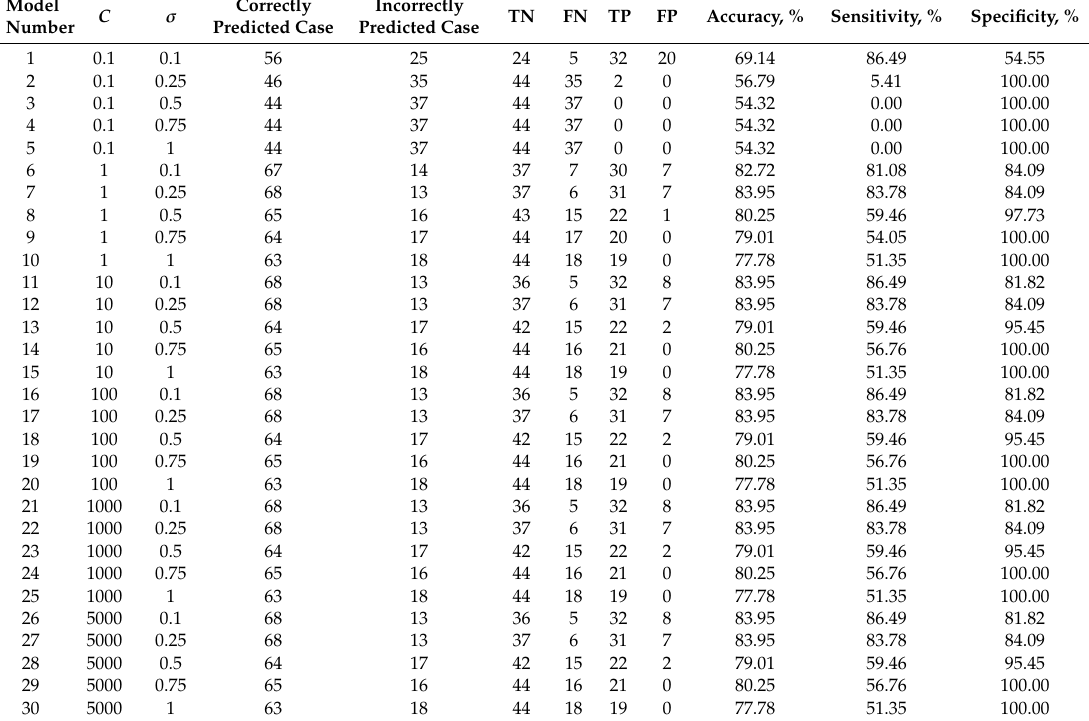
Table 17. Prediction results for the SVM model using the RBF kernel